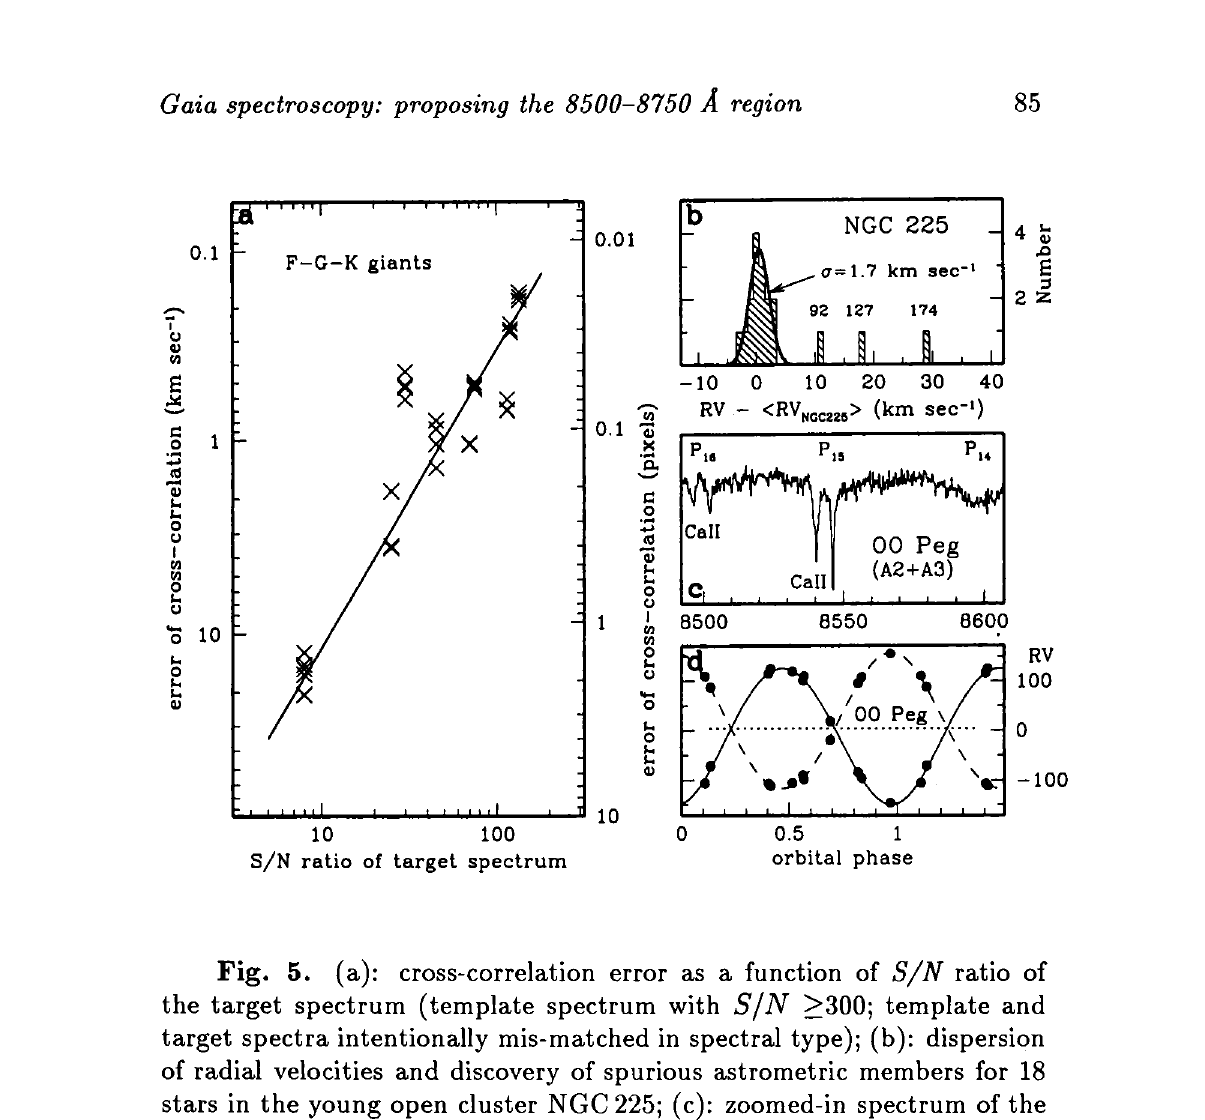
Fig. 5. (a): cross-correlation error as a function of S/N ratio of the target spectrum (template spectrum with S/N >300; template and target spectra intentionally mis-matched in spectral type); (b): dispersion of radial velocities and discovery of spurious astrometric members for 18 stars in the young open cluster NGC 225; (c): zoomed-in spectrum of the double-lined eclipsing binary 00 Peg (A2V + A3V); both components are easily separated in the Call lines but not in the Paschen lines; (d): spectroscopic orbit of the double-lined eclipsing binary 00 Peg from the radial velocities of the Call lines.